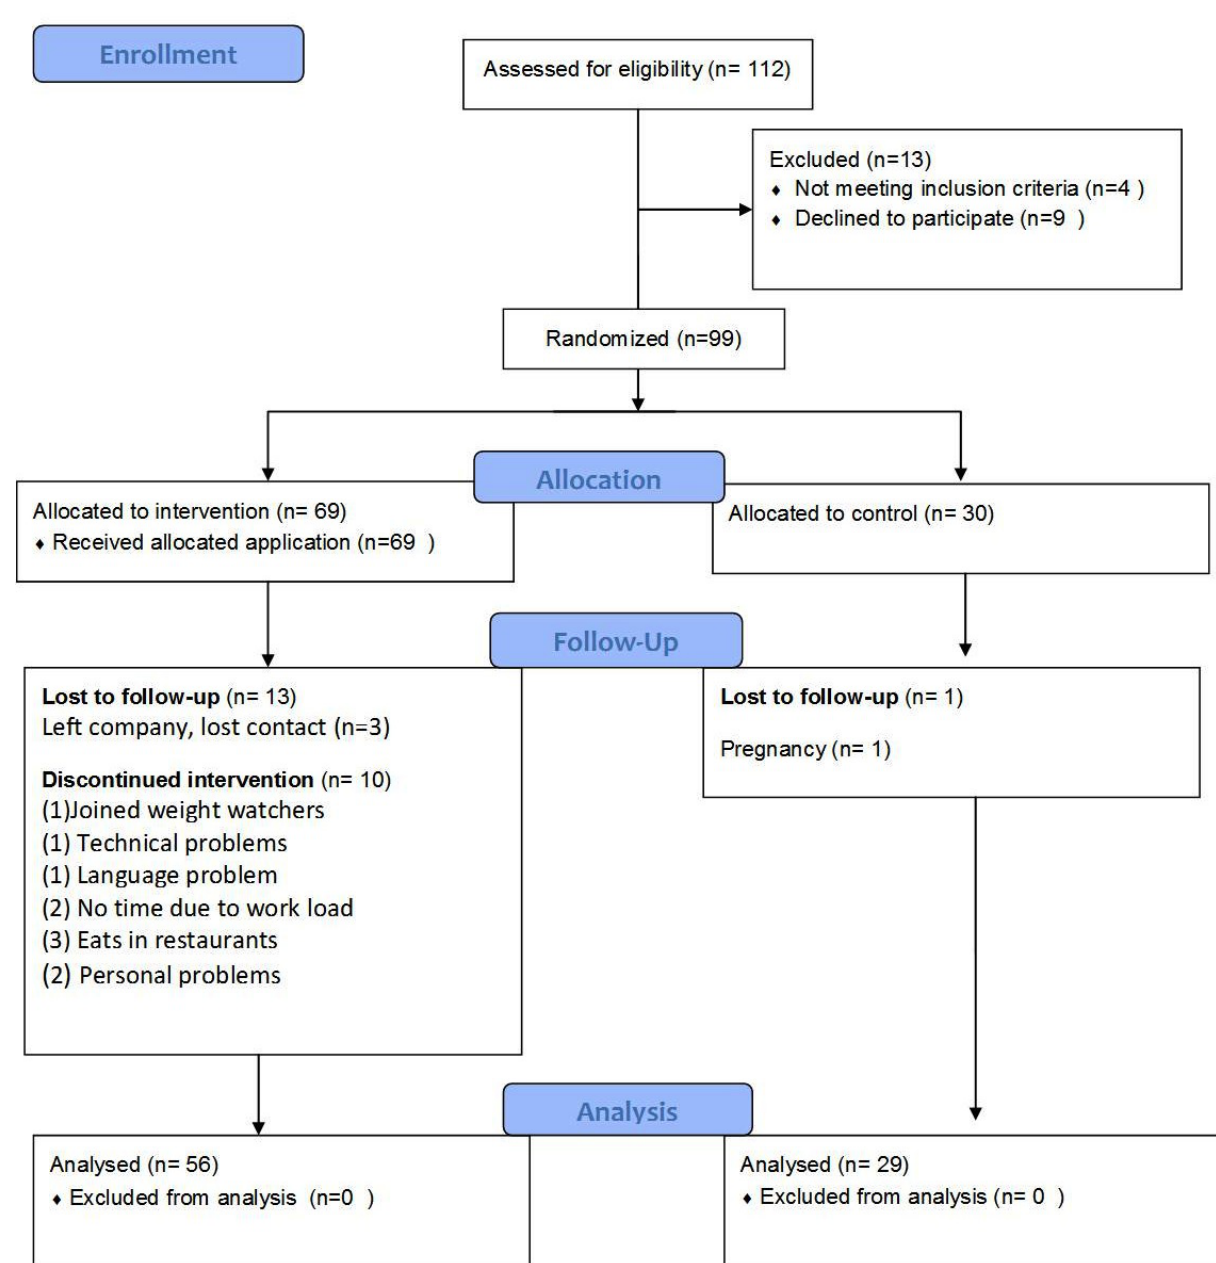
Figure 3. Flow of the participants through the RCT.